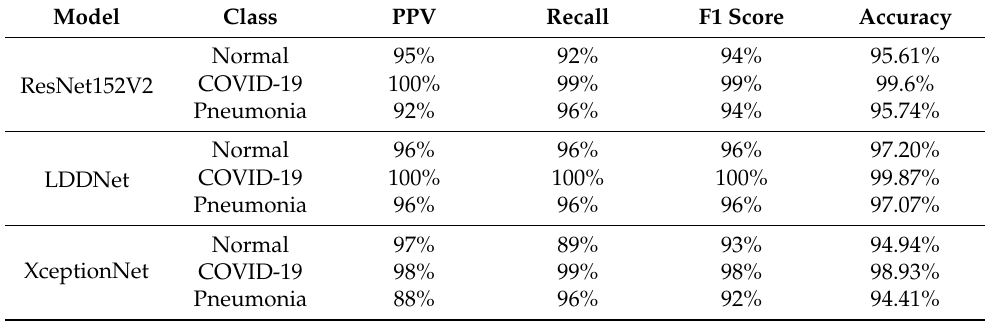
Table 15. Comparison of different DL models for the Nadam optimizer for X-ray